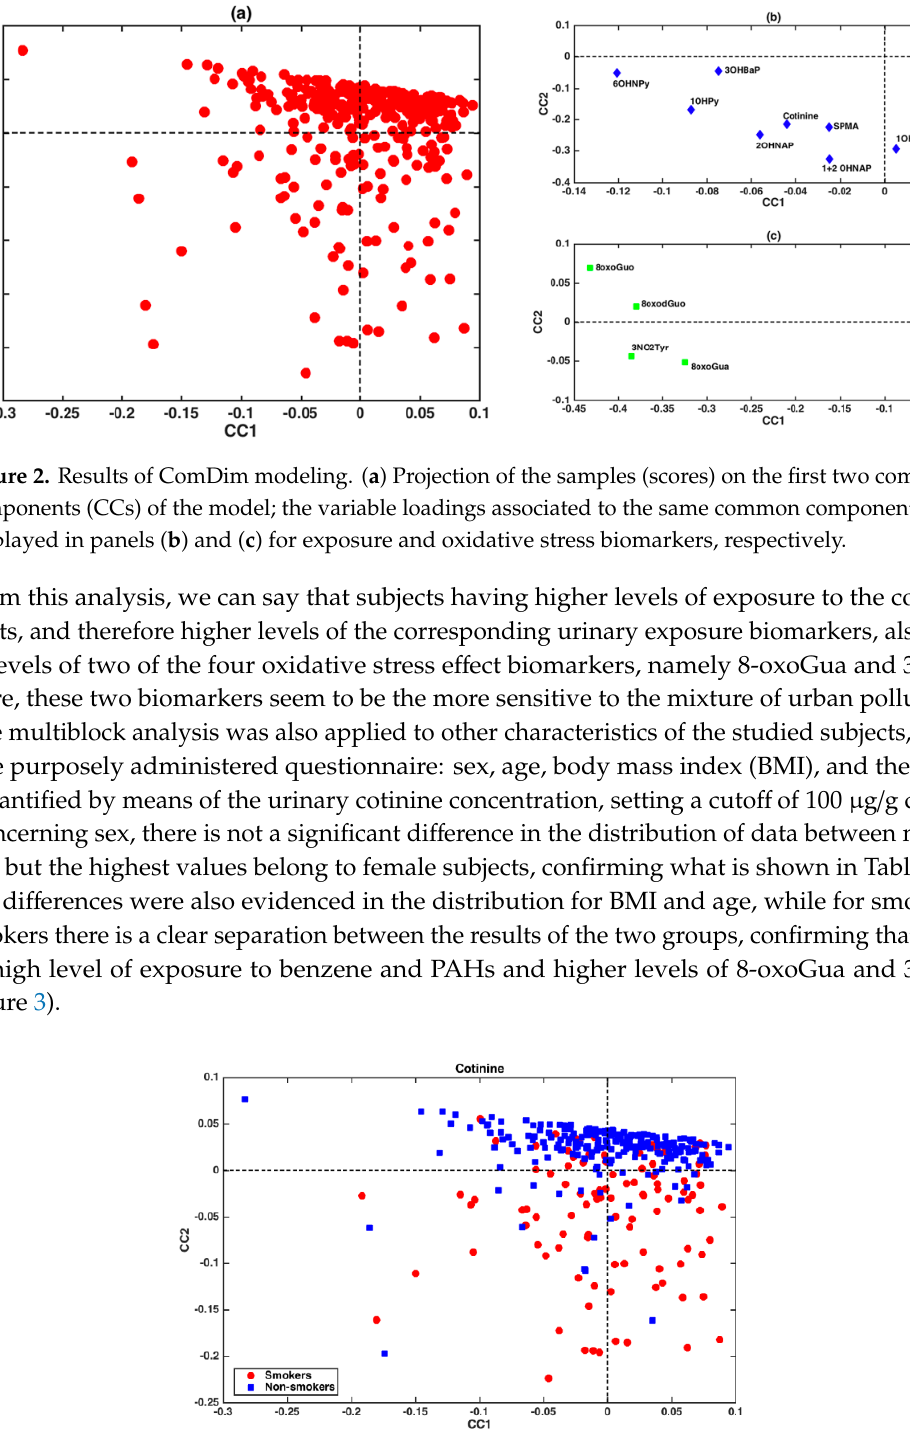
Figure 3. Score plot resulting from the ComDim analysis (same as Figure 2a), colored according to smoker/non-smoker status defined based on urinary cotinine levels.